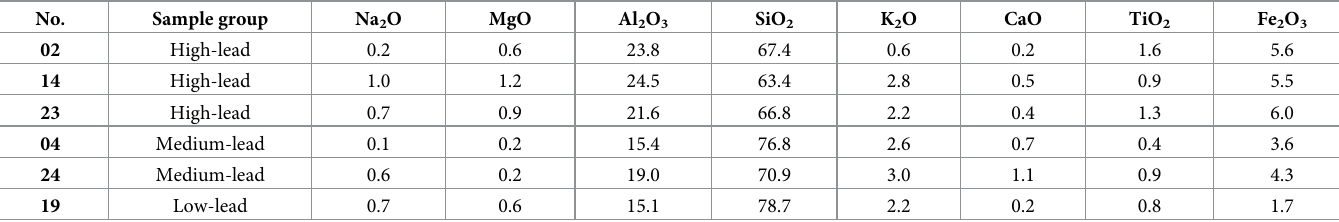
There are differences between the ceramic bodies of the three groups. The ceramic body com- positions of the 6 representative samples were analyzed by SEM/EDS, as shown in Table 3. In high-lead group, the raw material of the ceramic body have higher Al which was more similar to the fusible clay. Though the specific sources of the raw materials and the workshops of the products cannot be confirmed now, a different clay source is affirma- tive. The use of more strongly colored glazes enabled the use of more iron-rich clay, which would not be suitable for proto-porcelain. The results of the sample No. 19 reflect its raw mate- rial was porcelain stones [4,19–20]. The compositions of samples in the medium-lead group are close to those in the low-lead group, except the higher Fe Table 3. The results of ceramic bodies tested by SEM/EDS(wt.%). No. Sample